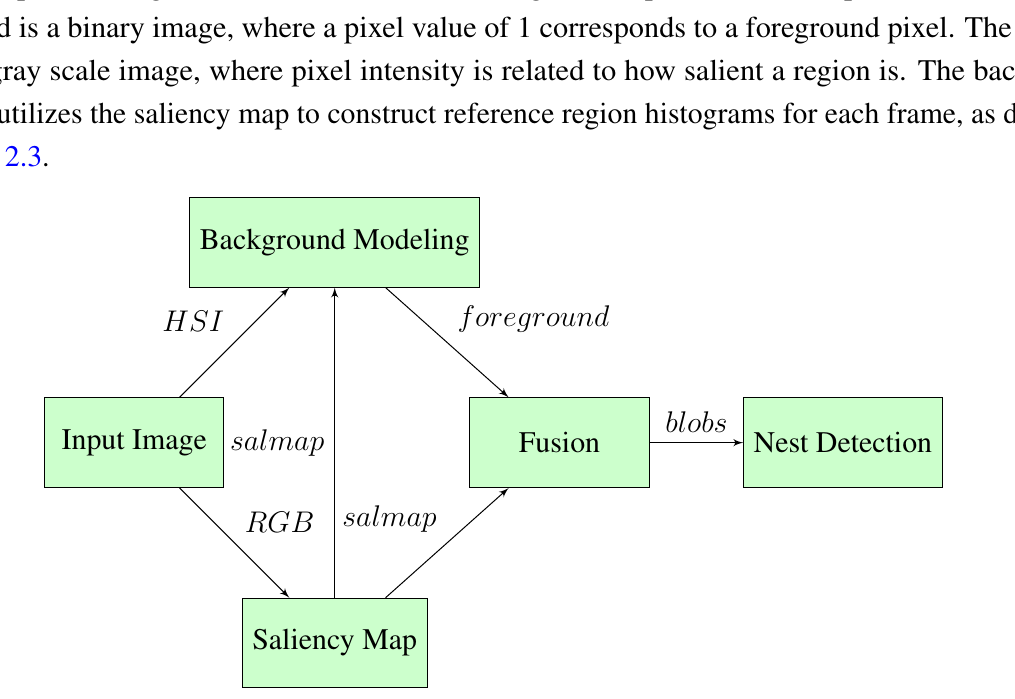
Figure 7. Flow of the nest detection